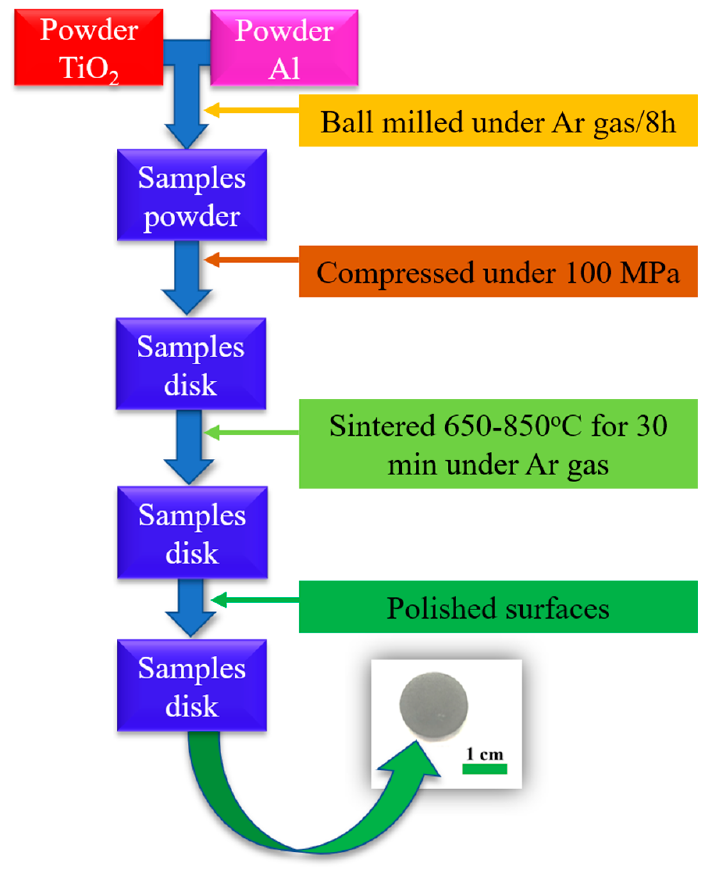
Figure 1. Sketch of sample fabrication processing.